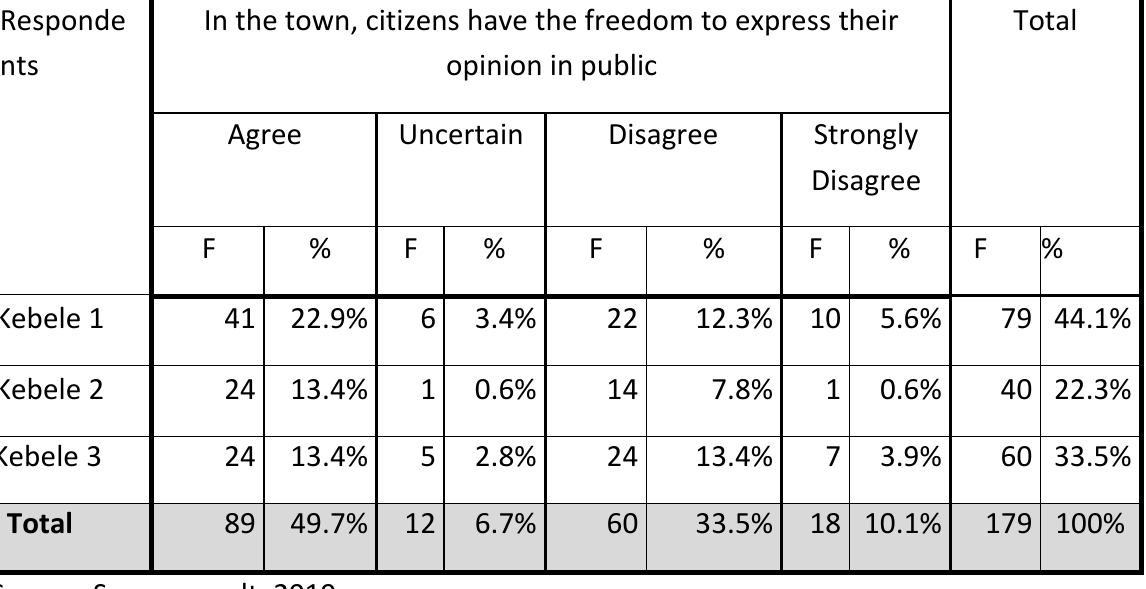
Table 9: Citizens were asked to offer opinions on freedom of opinion expression